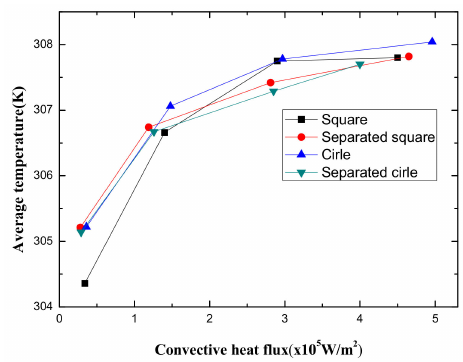
Figure 8. Average temperature due to convective heat flux in all